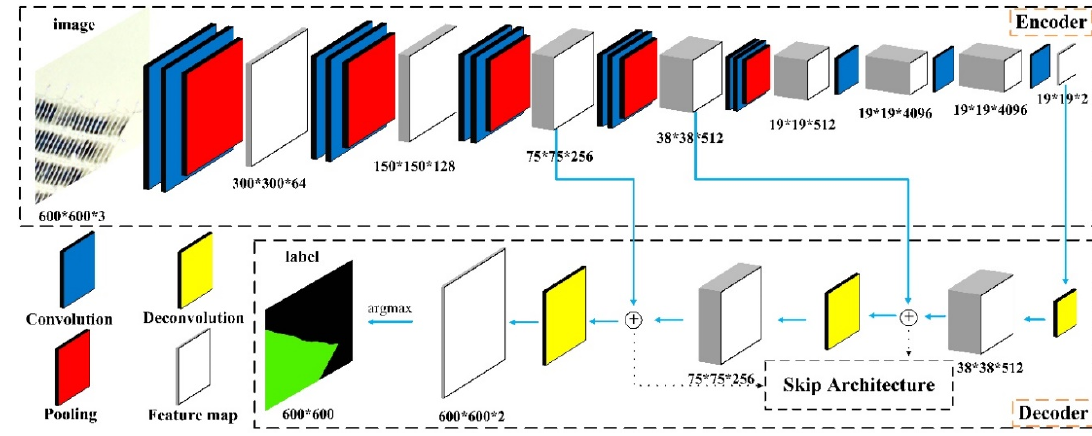
Figure 3. Fully convolutional neural networks (FCN)